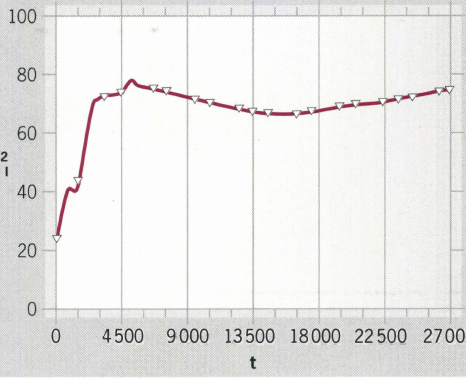
Squared intermolecular forces; difference between